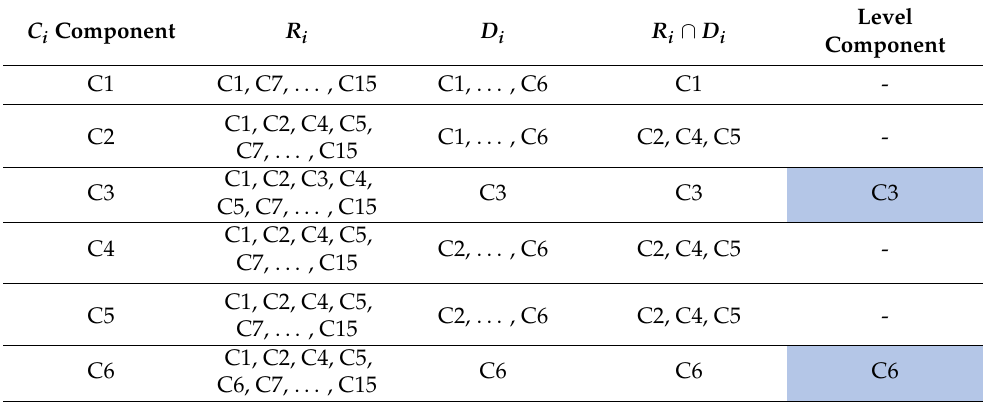
Table 9. The first iteration, and its output indicates the components that are at level